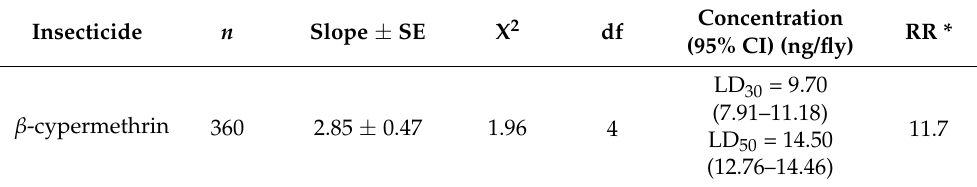
Table 2. Toxicity of β -cypermethrin against 6-day-old adults of B.dorsalis . Insecticide